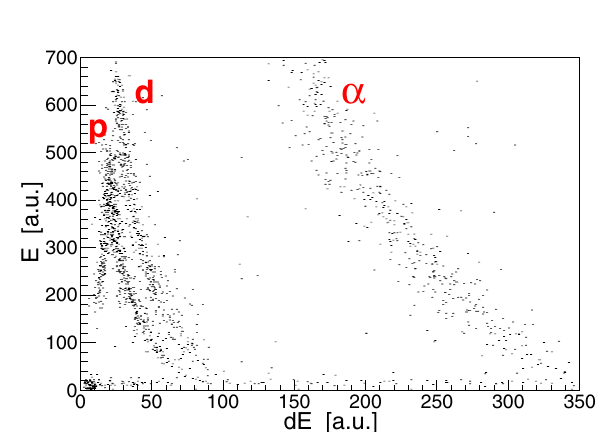
Figure 3. dE-E scatter plot corresponding to the C sample ex- posed to the neutron beam. The three regions from left to right correspond to proton, deuterons and alphas. For the protons the expected punch-through is also visible.